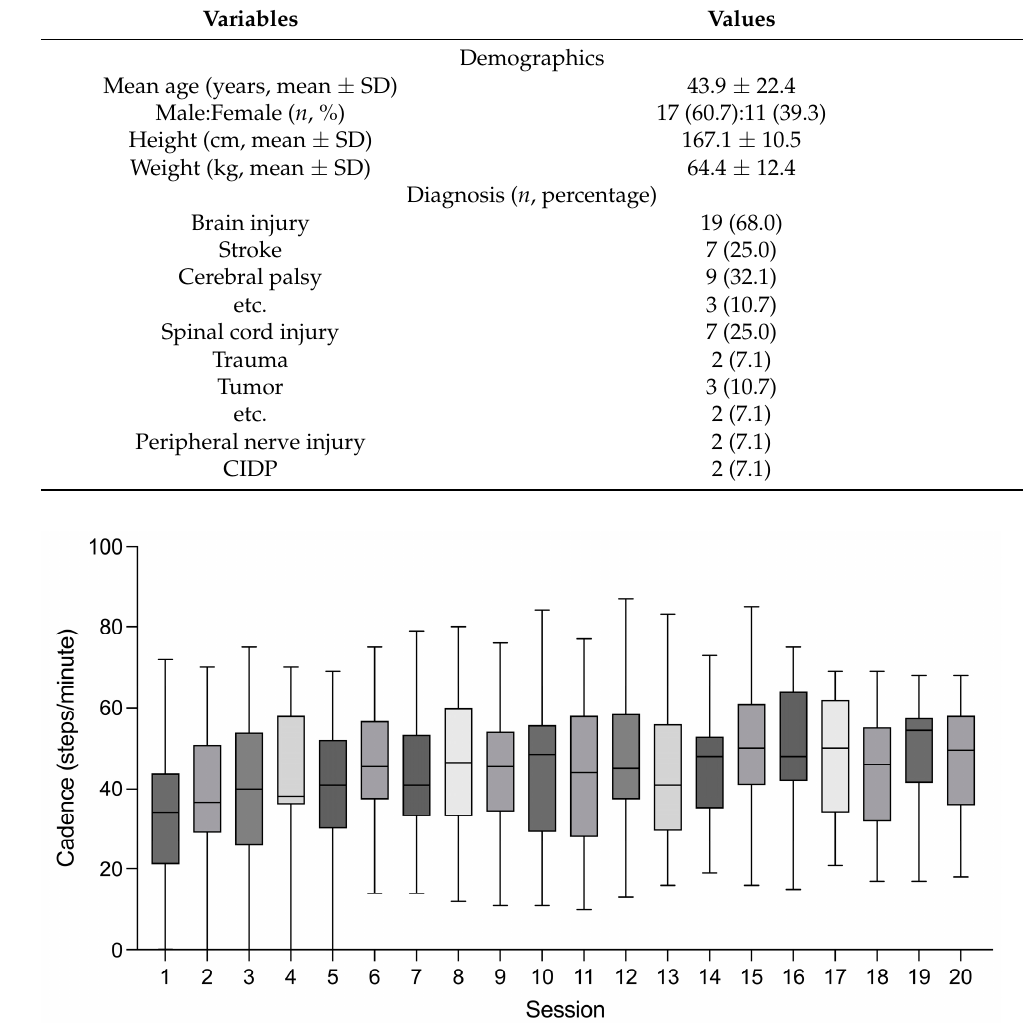
Figure 1. Cadence in each session of overground robot-assisted gait training. Boxes denote mean ± standard deviation, and the vertical bars represent the range.